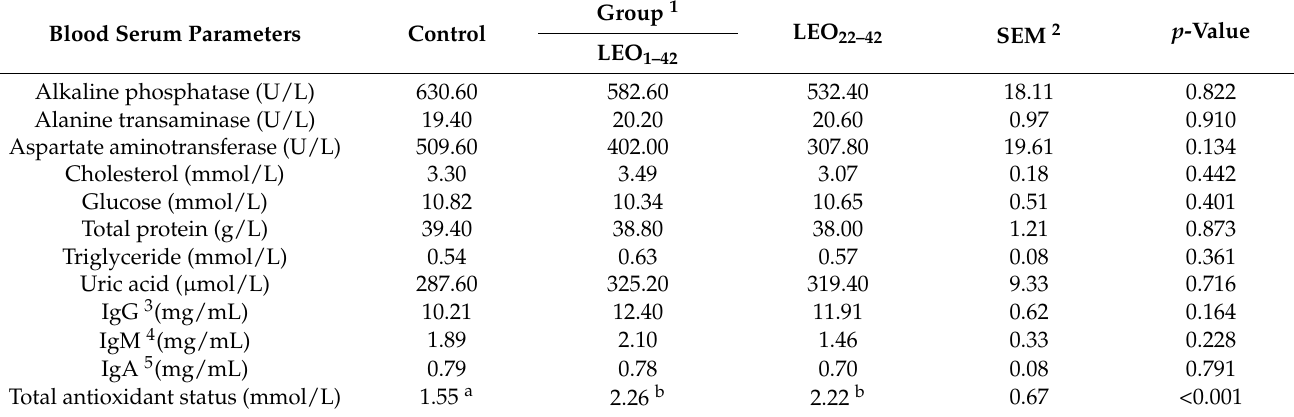
Table 3. Biochemical, immunological and antioxidant indices in the blood serum of broiler chickens. Blood Serum